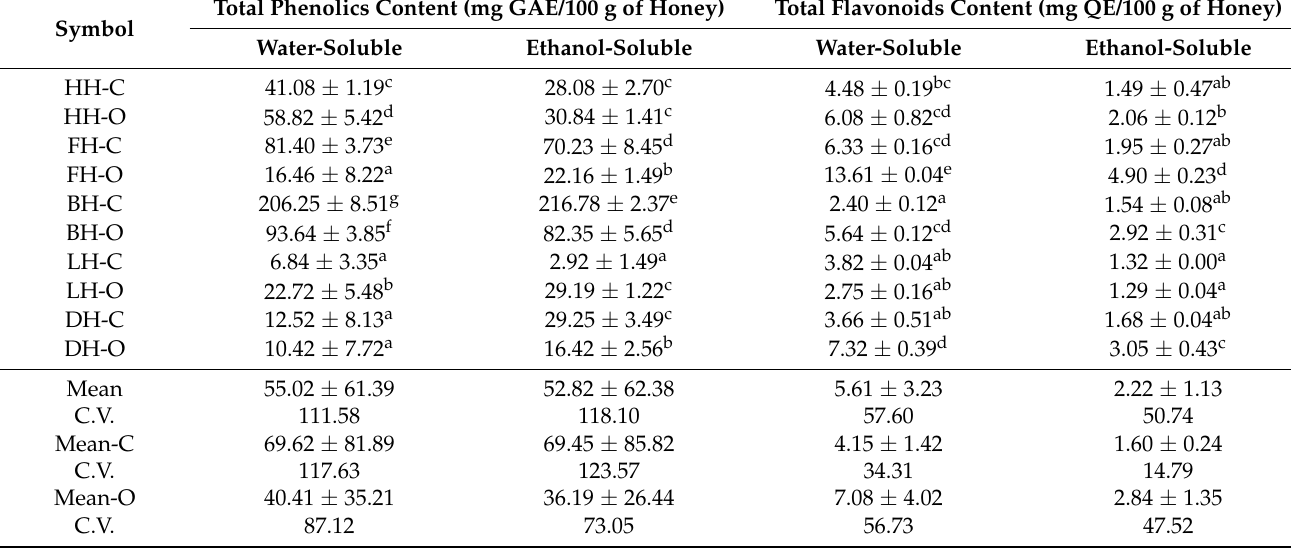
Table 4. Content of water- and ethanol-soluble phenolics in honey samples (mean value and standard deviation).